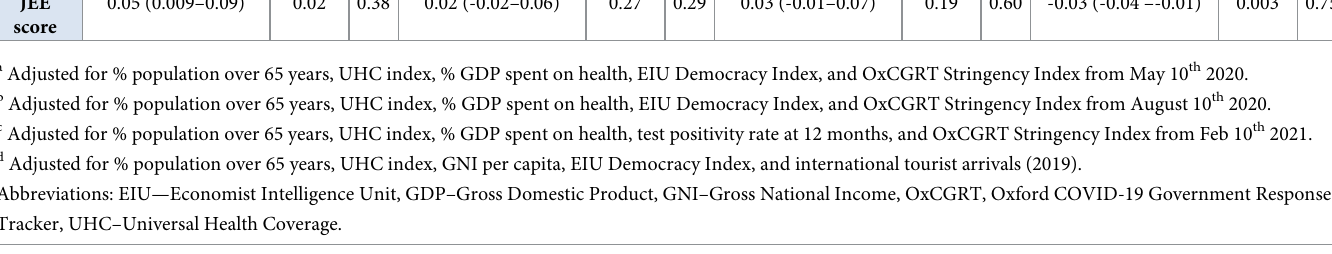
Tracker, UHC–Universal Health